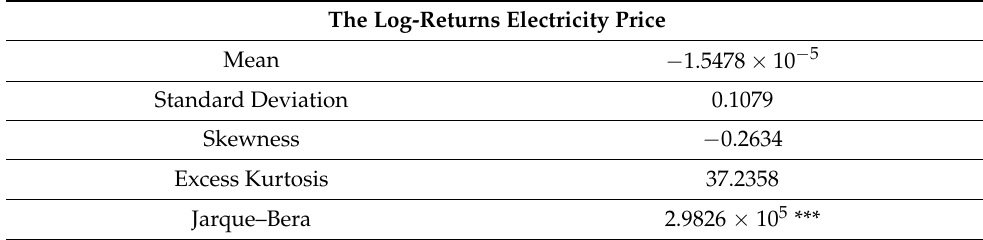
Table 1. Descriptive statistics of the spot prices time